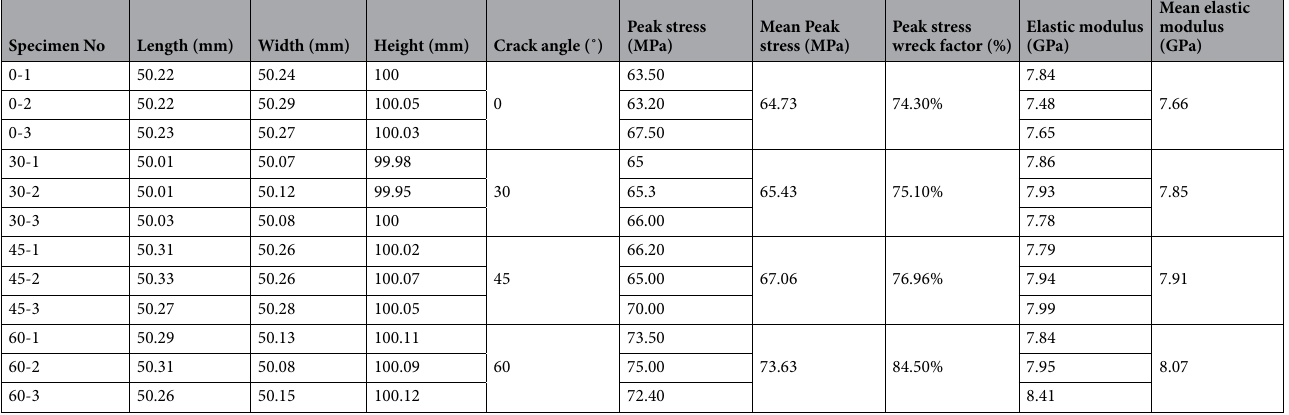
Table 1. Geometric and mechanical parameters of specimens.